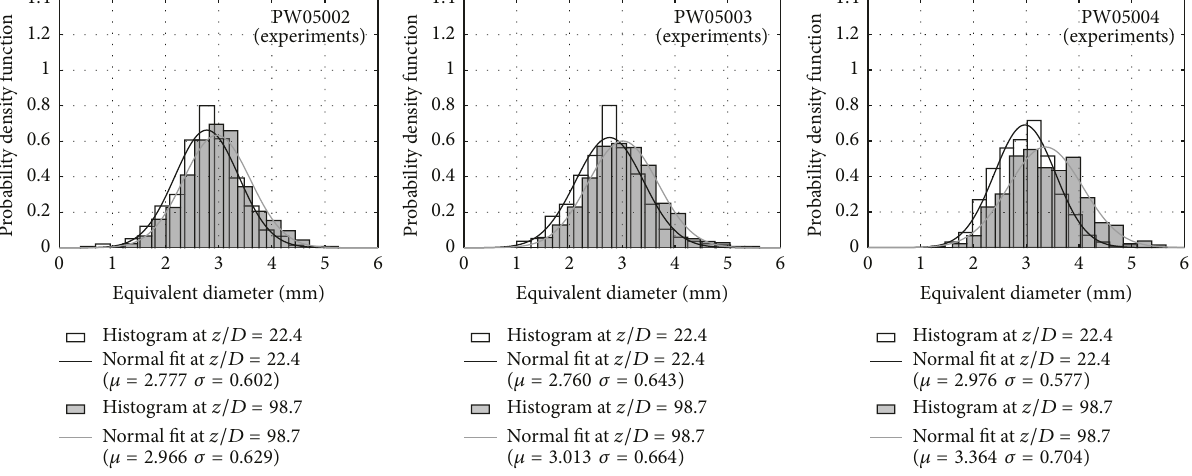
Figure 4: Bubble size distribution for PW05002, PW05003, and PW05004 at 𝑧/𝐷 = 22.4 and 𝑧/𝐷 = 98.7